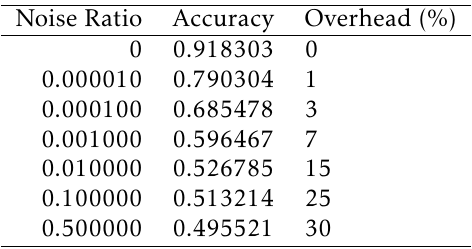
Table 6. Overhead of Noise